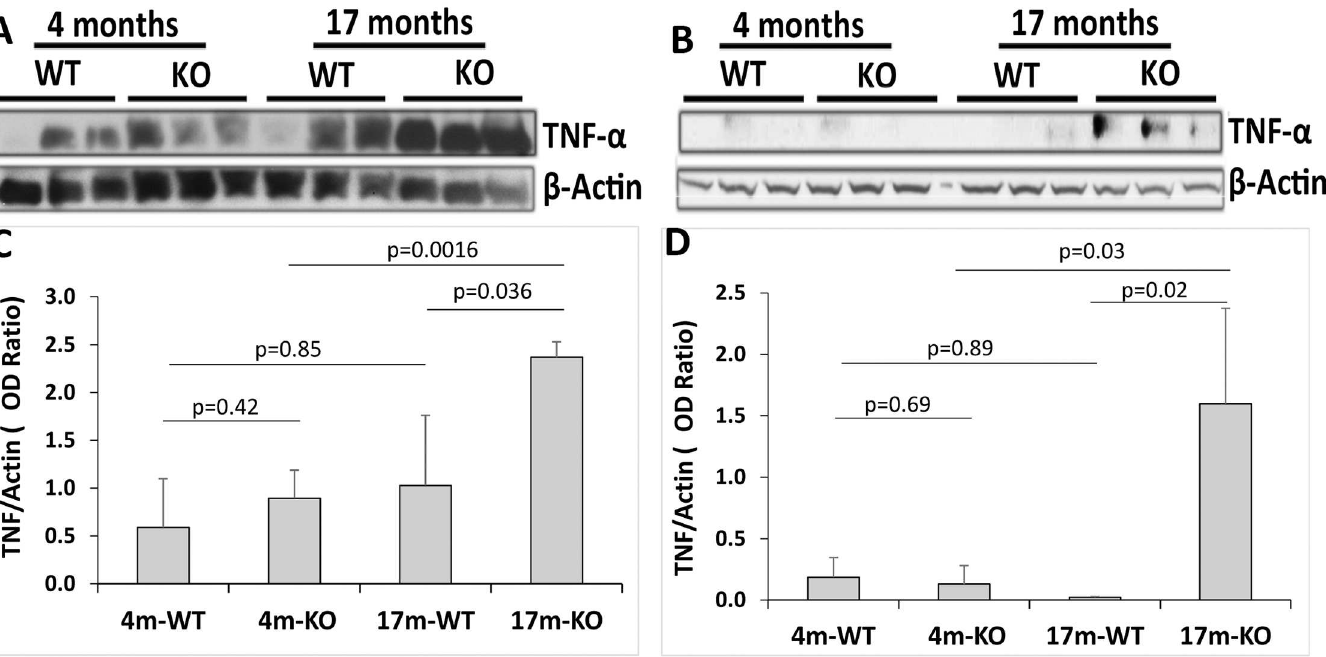
Fig 9. Increased protein levels of TNF- α in the RPE/choroid and retina of aged Cxcr5 -/- mice. ( A and B ) Western blots (WB) of TNF- α and β -actinwith the RPE/choroid ( A ) and retina ( B ). The RPE/Choroidand retinal protein samples from three individual mice were used for each group. Protein blot was first probedby anti-TNF- α antibody.After strippingand washing,the same blot was re-probedby anti- β -actinantibody.( C and D ) WB quantification of RPE/ choroid( C ) and retina ( D ). The results were the mean optical density (OD) ratio of TNF- α and β -actin( ± SD; n = 3). 4/17m-WT = 4/17-month-old C57BL/6 wild type mice. 4/17m-KO = 4-month-old Cxcr5 knockout